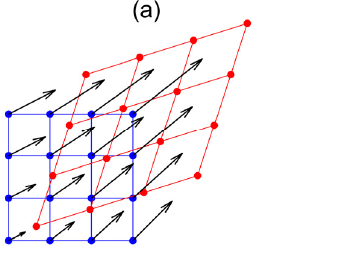
Figure 1. Example of grid transformation from [ X 1 , Y 1 ] (blue grids) to [ X 2 , Y 2 ] (red grids) using ( a ) M 3 × 3 , ( b ) M 4 × 4 , and ( c ) M 6 × 6 . The black arrows represent the transformation direction of a grid.